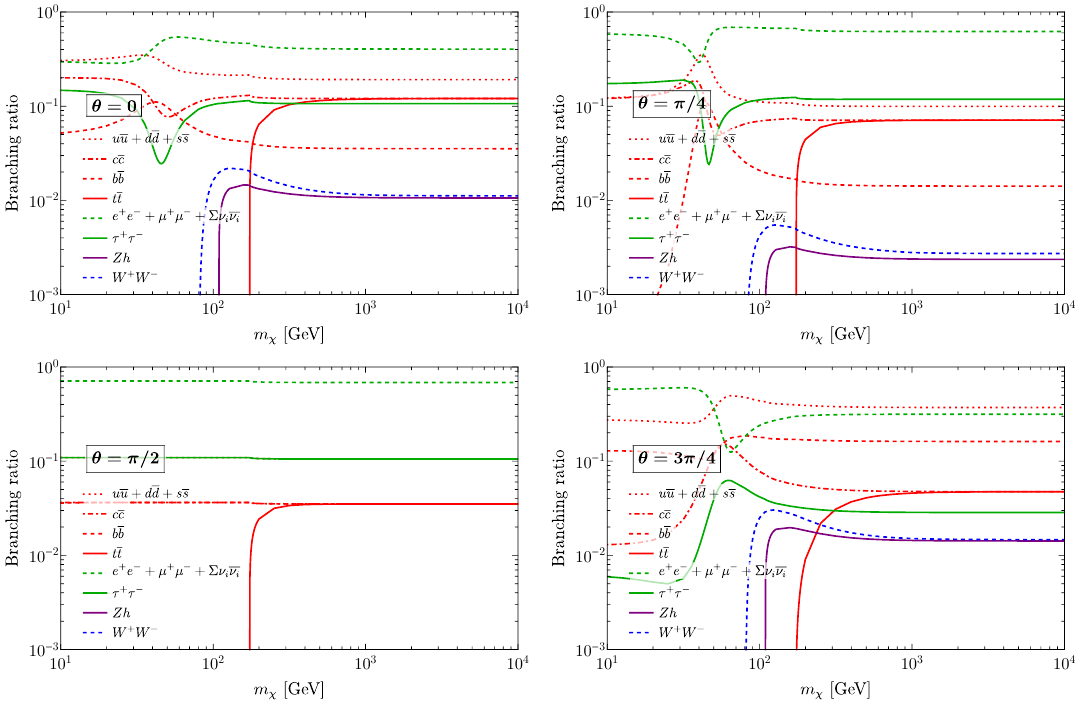
Figure 5 . ( Replaces (cid:12)gure 6 of the original paper .) Branching ratios for DM annihilations, for four di(cid:11)erent values of (cid:18) . Annihilation at di(cid:11)erent energies have the same behavior, given that all the channels are in p -wave, and the branching ratios are independent of m Z 0 .